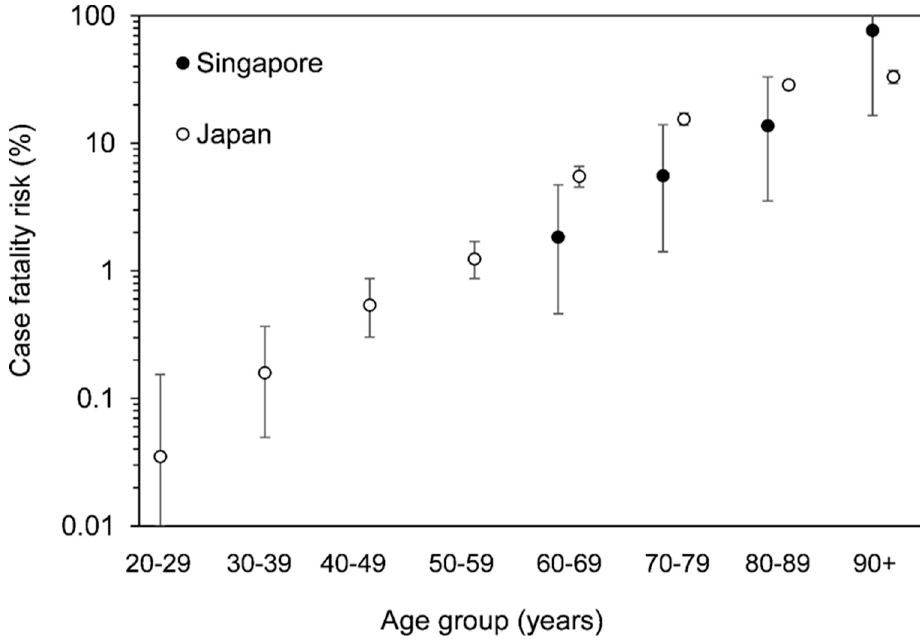
Figure 2. Comparisons between the unbiased case fatality risk of COVID-19 by age group between Singapore and Japan. The unbiased COVID-19 CFR according to age group in Singapore (black dots) and Japan (white dots). Whiskers show the 95% confidence intervals of each CFR.